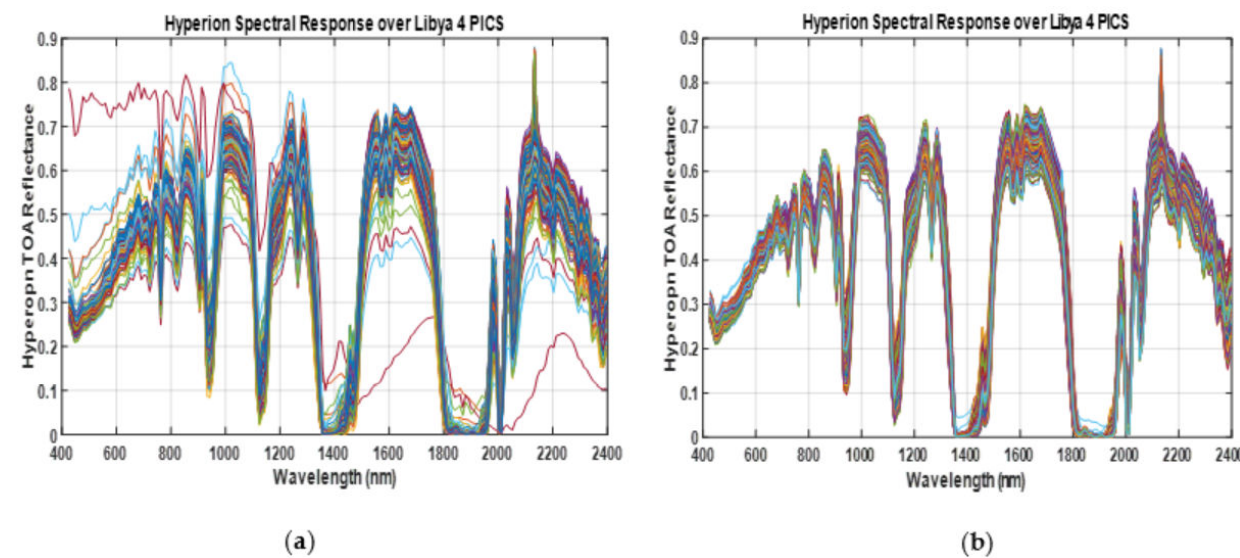
Figure 3. Hyperion spectral profile over Libya 4: ( a ) before ( ± 2 σ ) filtering approach; ( b ) after applying ( ± 2 σ ) filtering